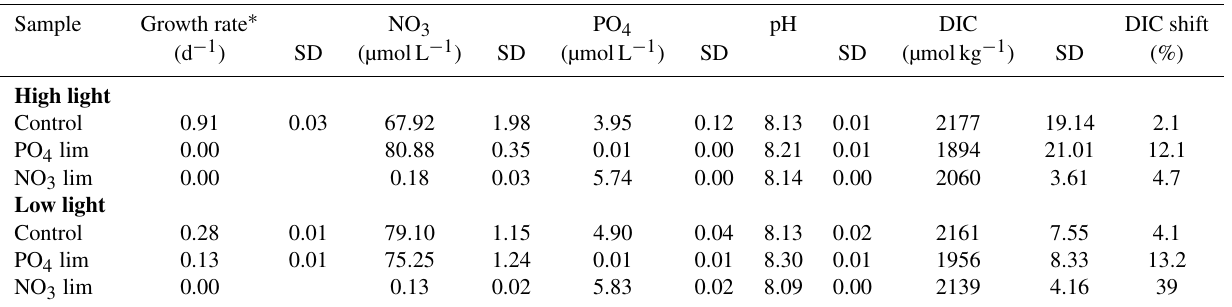
Table 1. Growth rate, nutrient concentration, pH, DIC at the end of the experiments and shift in DIC compared with the initial DIC (averages from triplicate, n = 3).